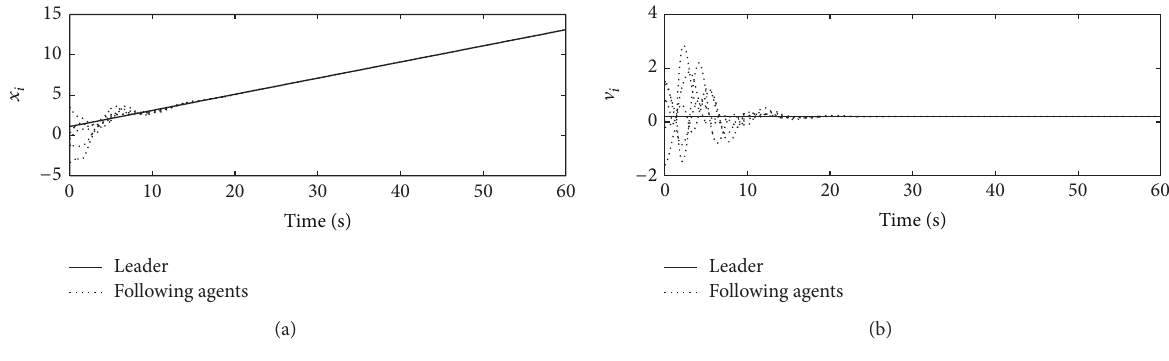
Figure 4: Delay-dependent dynamical consensus convergence.